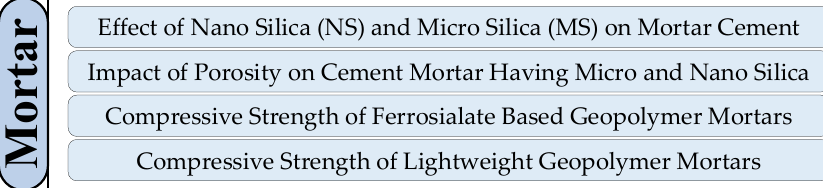
Figure 5. The studied subsections of mortar.